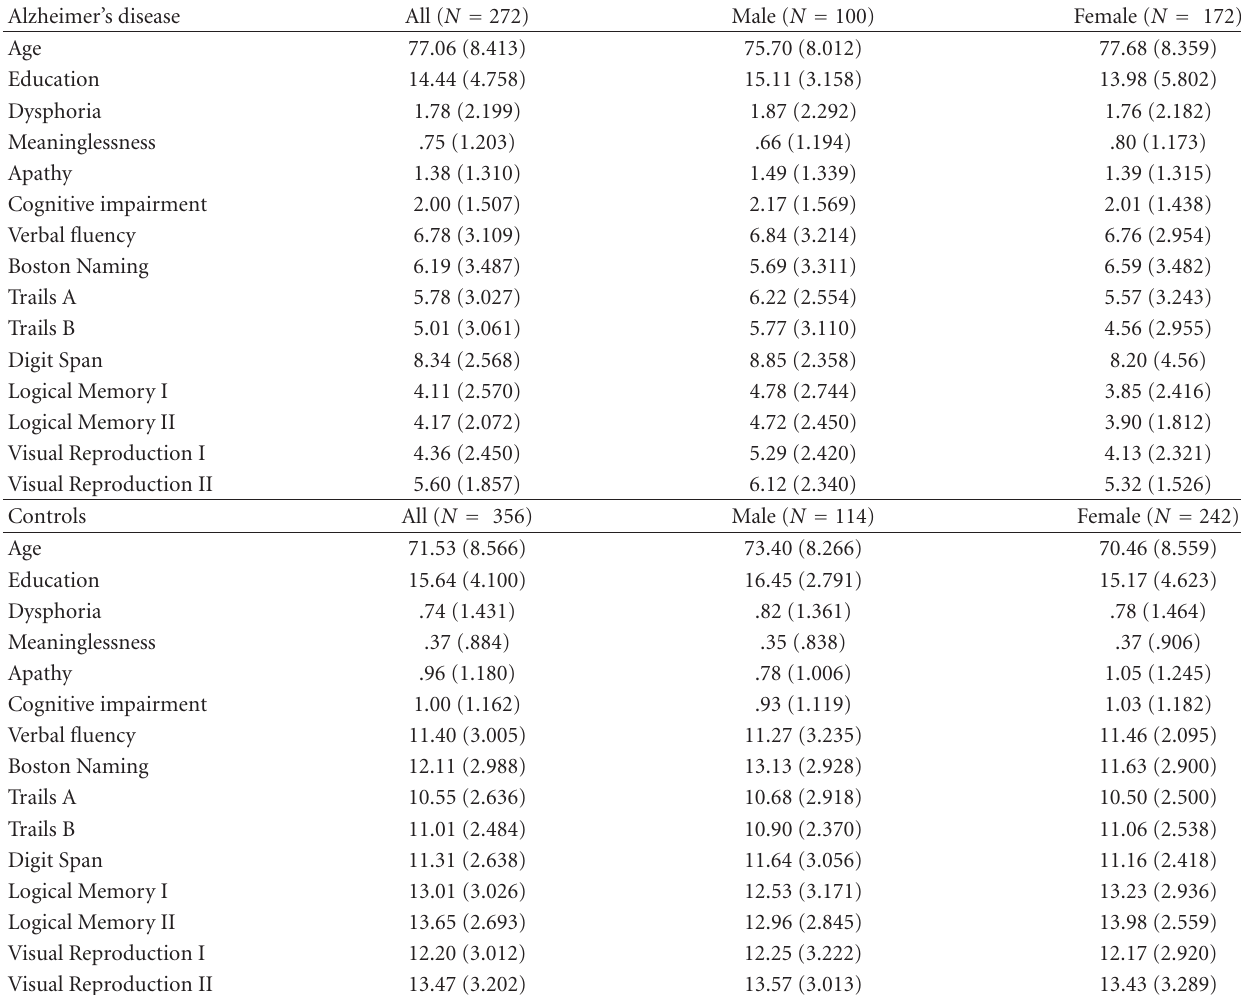
Table 1: Descriptive statistics (means and standard deviations) for